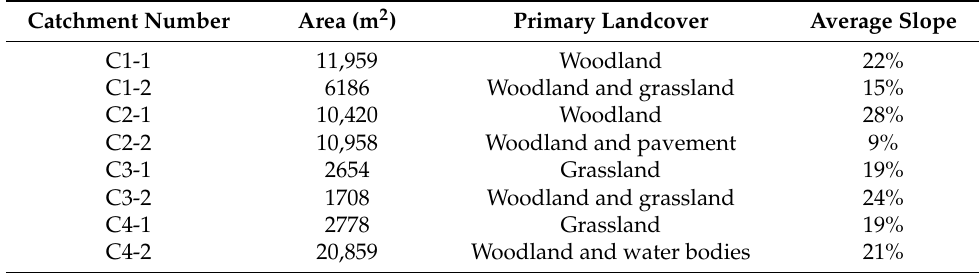
Figure 3. Schematic of hydrological multi-level control strategies for the mountain park.